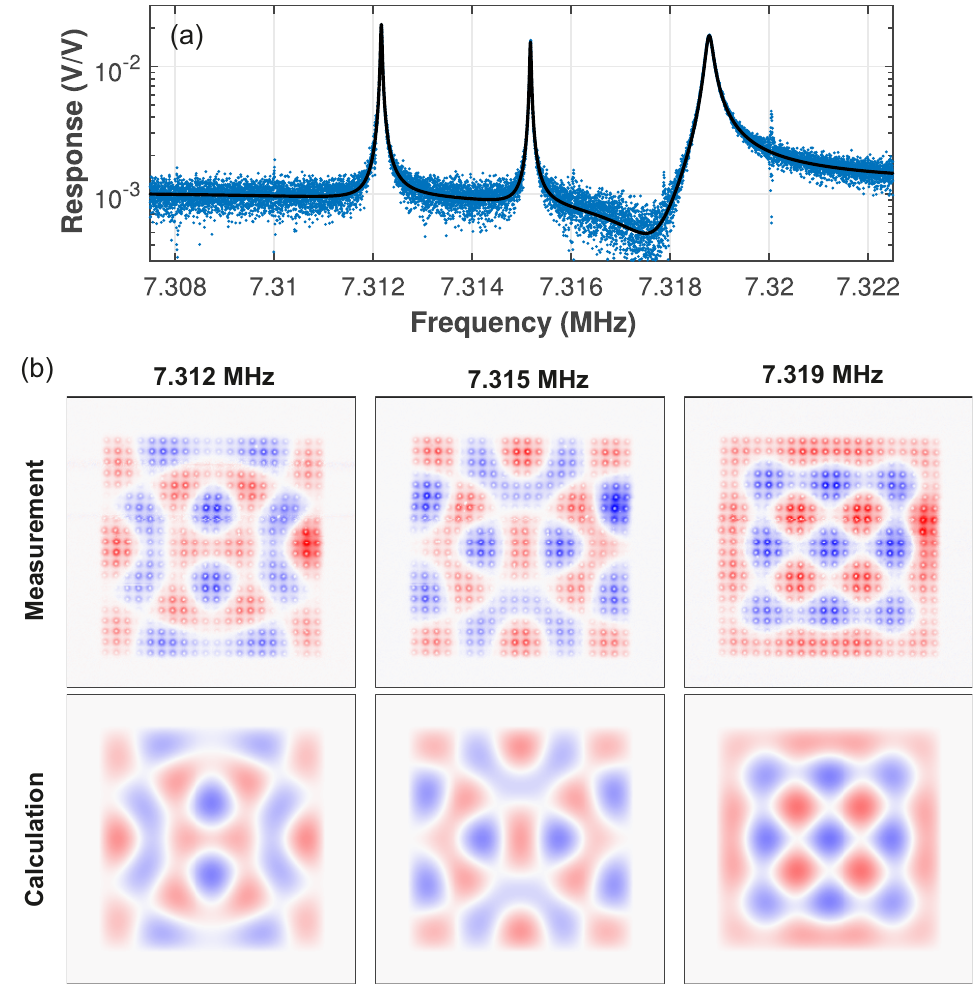
Figure 4. ( a ) Driven response near f 5,5 = f 1,7 = f 7,1 . The triplet is fitted using three stan- dard harmonic oscillator responses taking crosstalk into account (Appendix A) [32] (black line). ( b ) Measured (left) and calculated (right) mode maps. The weights from the linear fitting are { w } ∝ { 0.561, − 0.506,0.656 } , { 0.817,0.260, − 0.515 } , and { 0.105,0.694,0.712 } for the left, 5,5 , w 1,7 , w 7,1 middle, and right peak, respectively. The fit uncertainty in the weights is